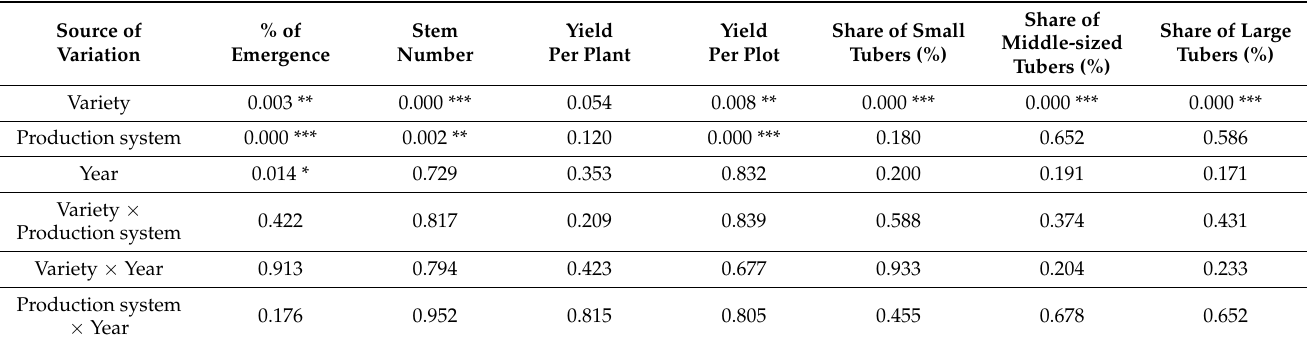
Table 6. Sources of variation, ANOVA results, and levels of significance ( p -values) for treatments affecting tested parameters—plant